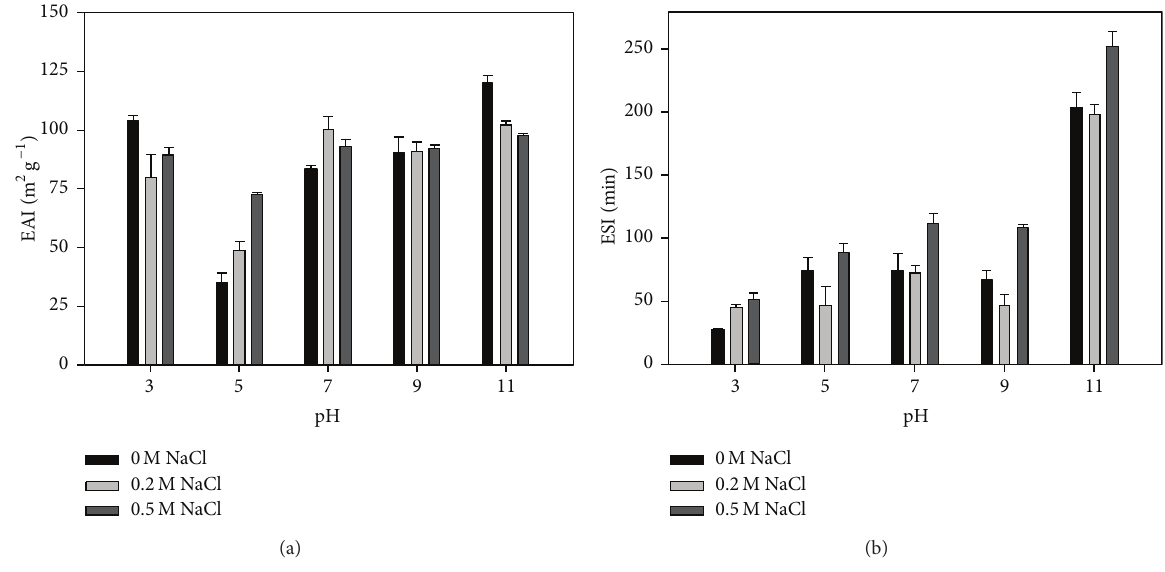
Figure 5: Effect of pH and NaCl concentration on (a) emulsifying activity index (EAI) and (b) emulsifying stability index (ESI) of SP from jumbo squid mantle. Data represent the mean ± standard deviation ( 𝑛 = 3